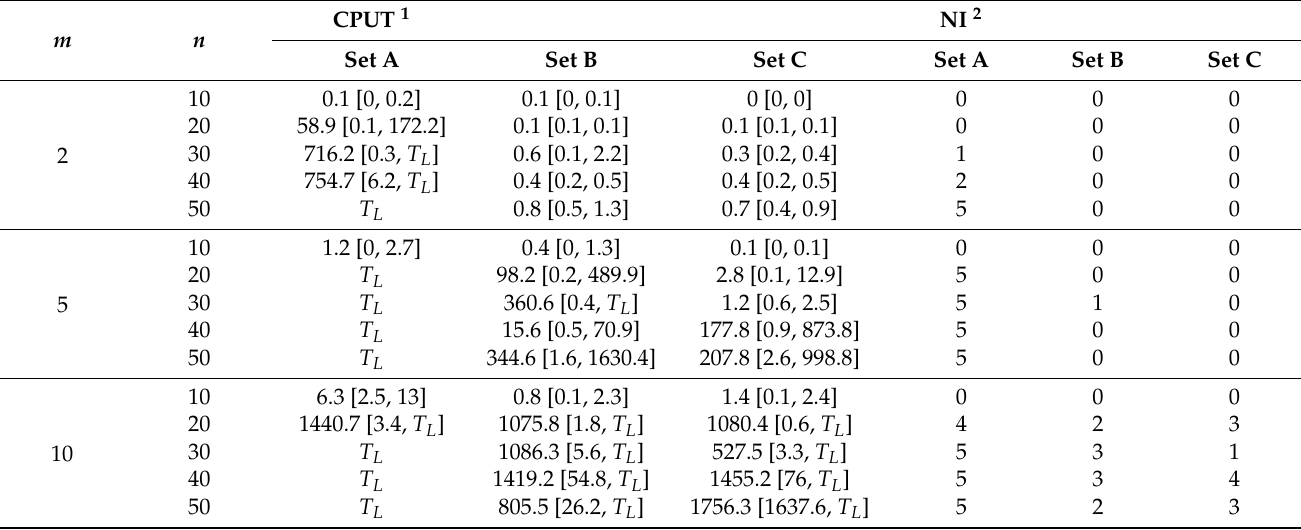
Table 3. Performance of MIP using